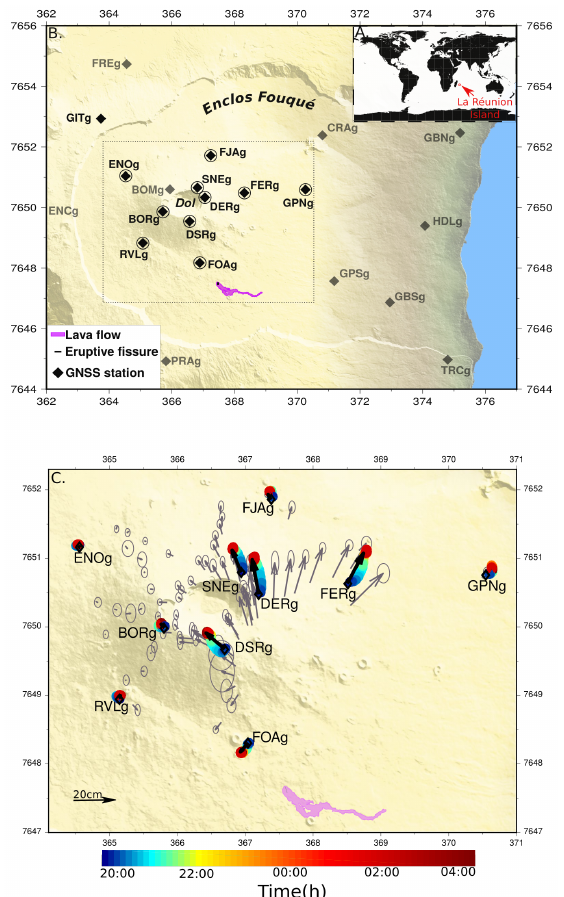
Figure 1. Piton de la Fournaise (PdF) setting. ( A ) Location of Reunion Island; ( B ) Shaded topography of PdF volcano and location of the GNSS monitoring network. Black and grey diamonds represent the locations of the permanent GNSS stations. The black circled diamonds refer to the 10 GNSS stations used in this study. The GITg station (black diamond to the northwest) is the reference used here for the GNSS campaign and for the epoch-by-epoch processing. The May 2016 lava flow is shown in purple. ’Dol’ marks the Dolomieu crater; ( C ) Zoom corresponding to the area indicated by a black box in B. Black arrows represent the cumulated horizontal displacement of the 10 GNSS stations between 25 May at 17:00 and 26 May at 04:05. Standard deviations for horizontal and vertical components are 1–2 cm and 3-4 cm, respectively. Associated colored circles represent the temporal evolution of the horizontal displacement for the GNSS stations. Grey arrows represent displacements from the GNSS campaign network between 31 August 2015 and 27 May 2016, with ellipses for the 95% confidence intervals. Coordinates are in kilometers (WGS84, UTM 40S). Modified after Reference Smittarello et al.